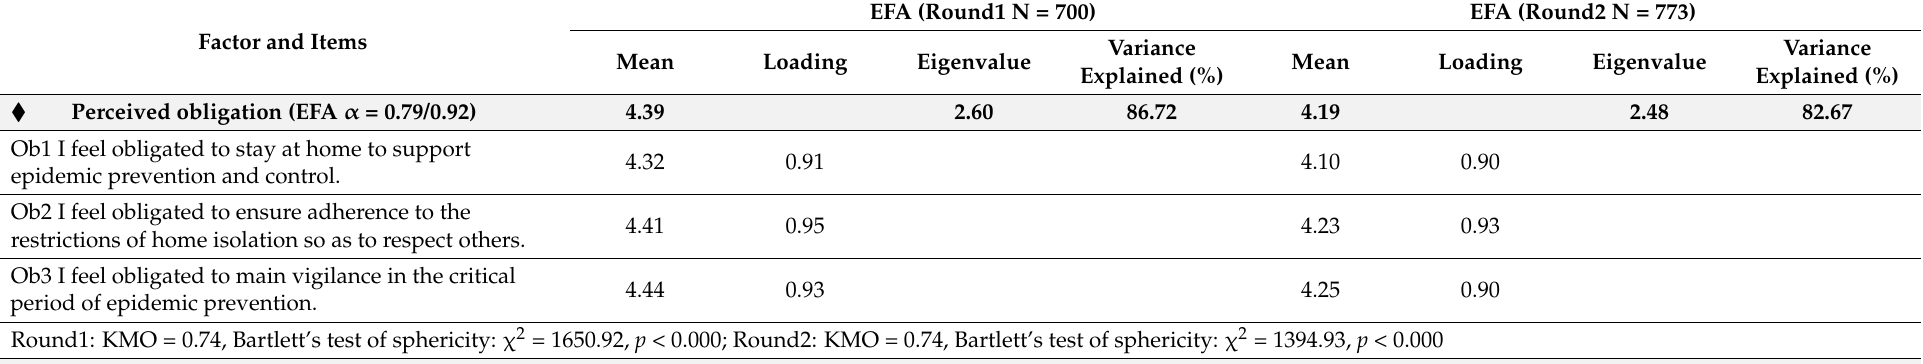
Variance Explained